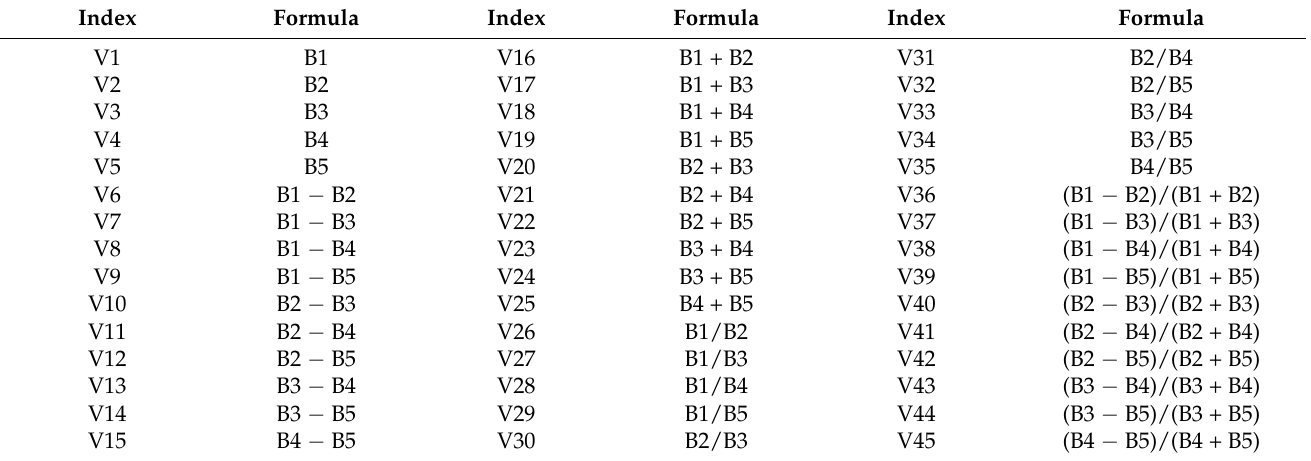
Table 3. Band combination construction and calculation. Note: labels V1–V45 represent the number of each